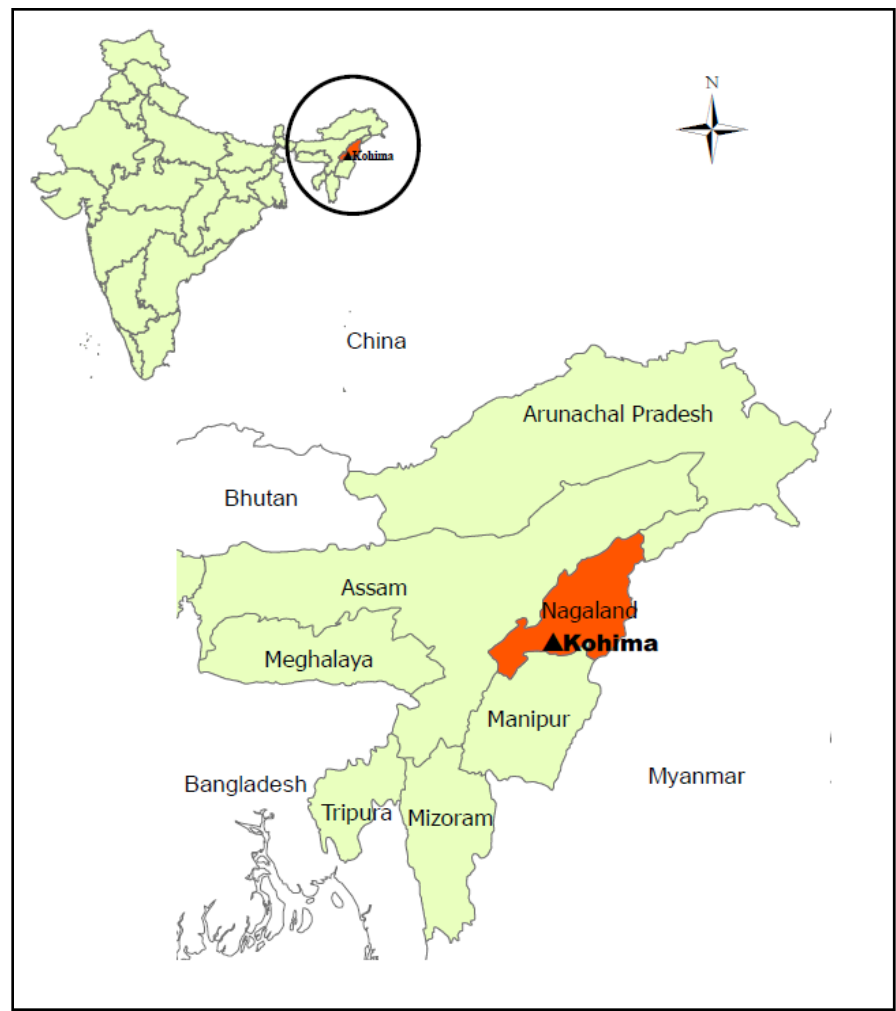
Figure 1. Situation map of North East India, Nagaland and Kohima, Nagaland’s